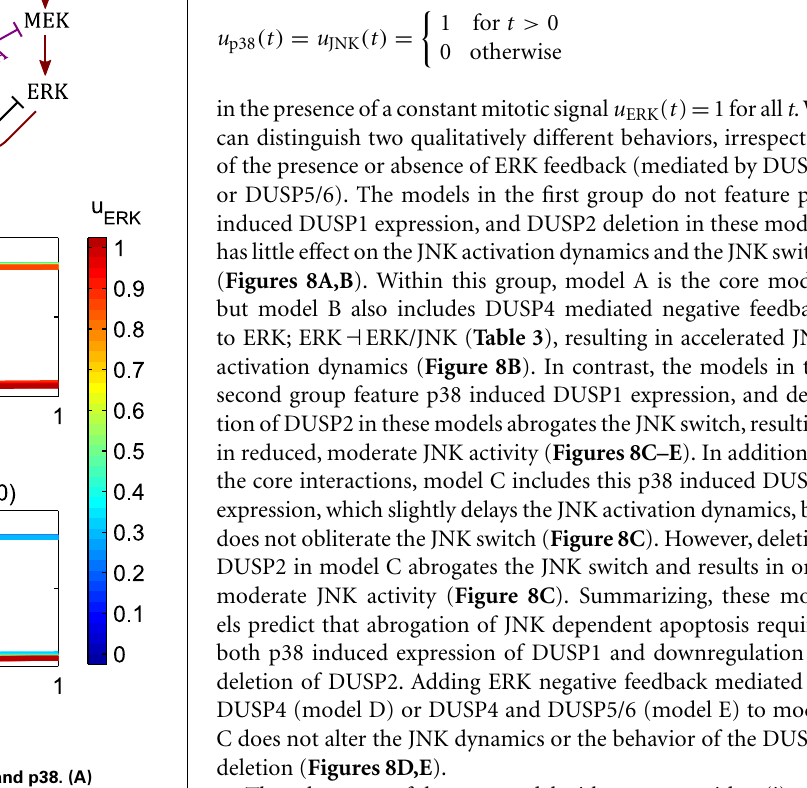
FIGURE 7 | Regulation of the JNK switch by ERK and p38. (A) Interaction scheme. (B,C) Simulated dose responses with respect to the JNK inputs for different levels of constant ERK pathway stimulation; u JNK ( t ) = ˆ u JNK for t > 0; u p38 ( t ) = 1 for t > 0; u ERK = ˆ u ERK for all t ; blue curves indicate low, red lines high ERK stimulation; dashed lines indicate a switch from low to high JNK activity. (B) Dose responses for primary/non-transformed cells exhibiting p38 (cid:97) ERK crosstalk. (C) Dose responses for transformed/tumorigenic cells lacking the p38 (cid:97) ERK crosstalk (no PP2A upregulation in the